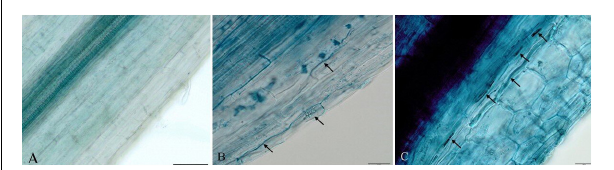
FIGURE 5 | Performance of strawberry plants inoculated with DSE fungal isolates in inorganic commercial soil. (A) Control plant. (B) Exophiala sp. K47-treated plant. (C) E. pisciphila SK48-treated plant. (D) C. chaetospira SK51-treated plant.